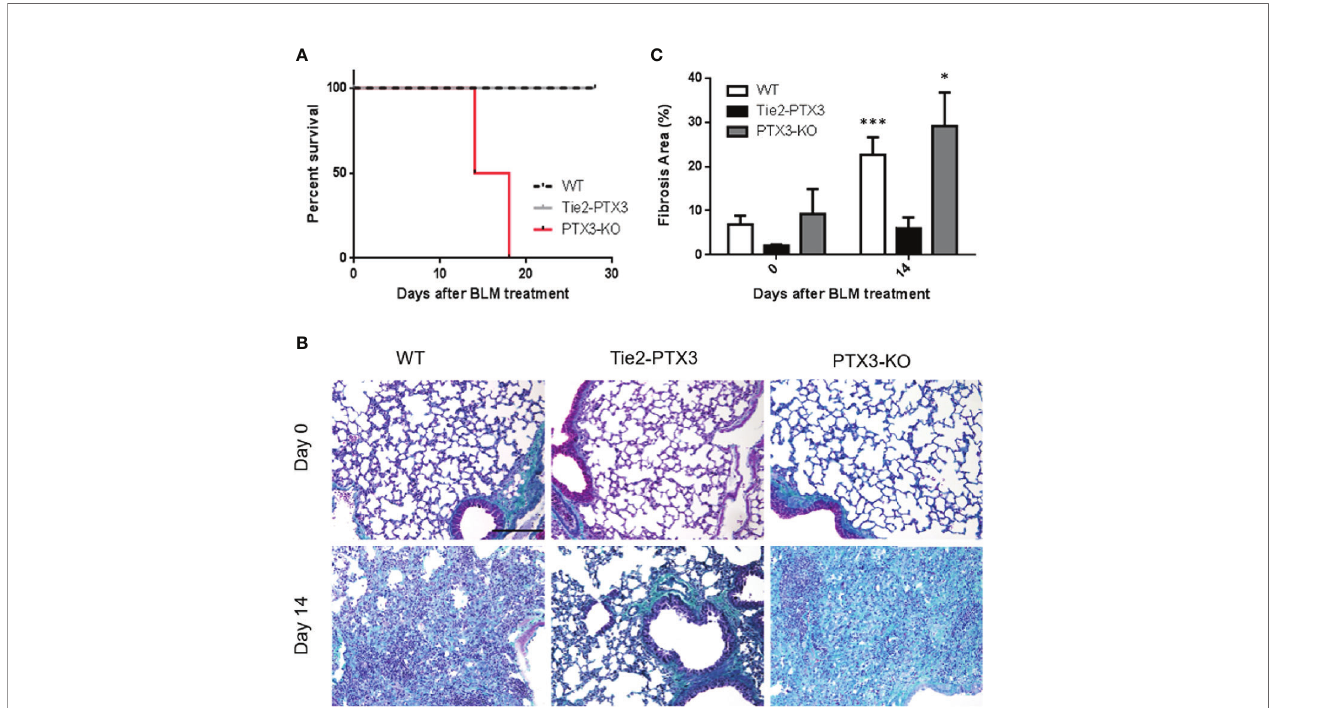
FIGURE 5 | Ptx3 knockdown increases the deposition of fi brotic tissue and a rapid animal death in BLM-induced lung fi brosis. (A) Kaplan-Meier survival curve of wild type (WT) and transgenic Tie2-PTX3 and Ptx3 − / − (KO) mice treated with bleomycin (BLM). Masson ’ s trichrome staining (B) and quanti fi cation of the fi brotic area (C) performed on lungs at day 0 and day 14 after treatment. N = 5 – 8 mice/group; scale bar = 100 µm; *P <0 .05, ***p <